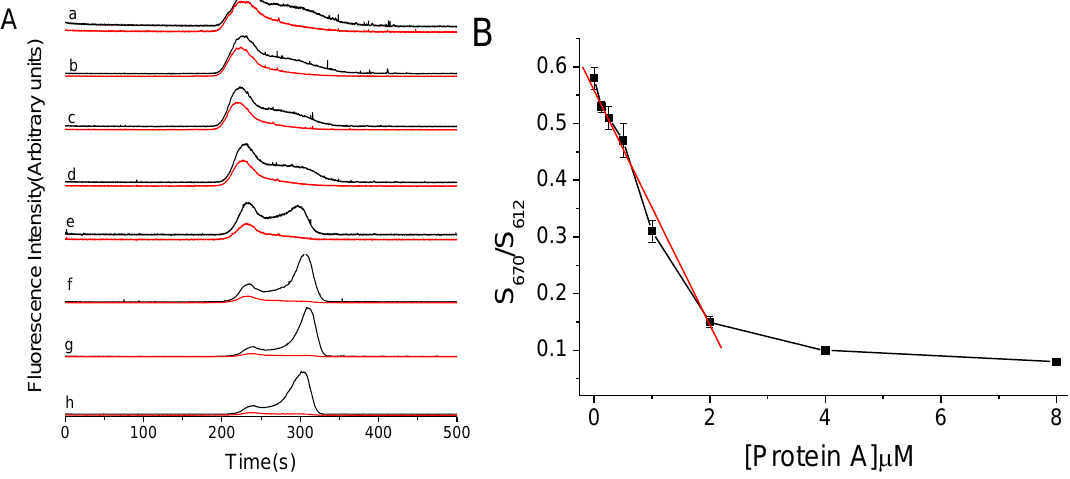
Figure 3. ( A ) Electropherograms of displacement of QD bound IgG-Cy5 by different amount of protein A (black: 612 nm for QDs; red: 670 nm for Cy5). a, 0 μM; b, 0.125 μM; c, 0.25 μM; d, 0.5 μM; e, 1 μM; f, 2 μM; g, 4 μM; h, 8 μM; and ( B ) Protein A detection by the changes of S / S [QDs-IgG-Cy5] = 2 670 612